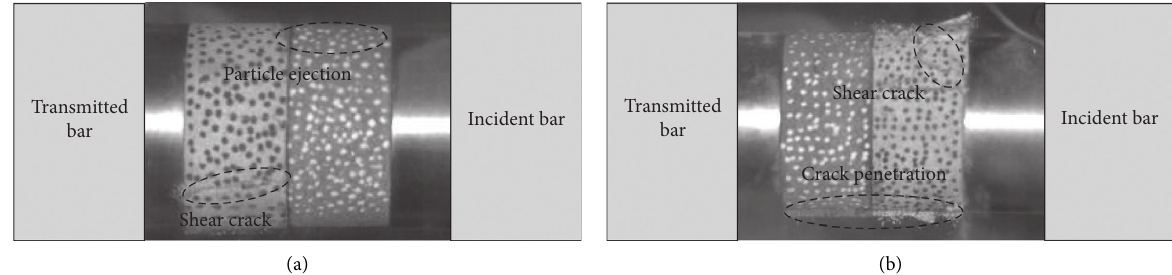
Figure 9: Failure characteristics of the layered composite rock mass. (a) B ⟶ W sample. (b) W ⟶ B